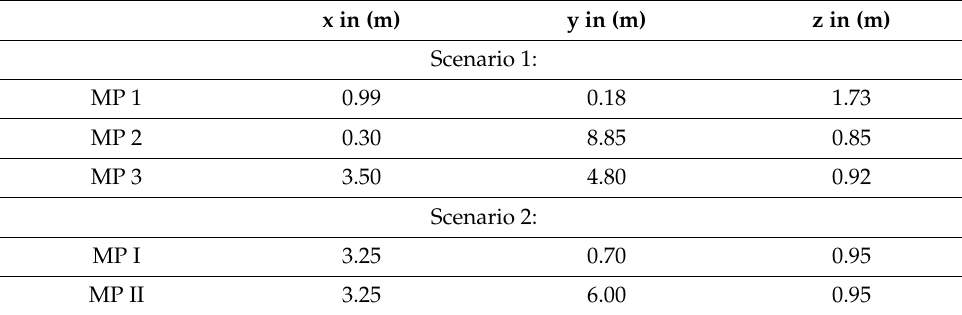
Table 1. Coordinates of the measuring points where z represents the height. x in (m) y in (m) z in (m) Scenario